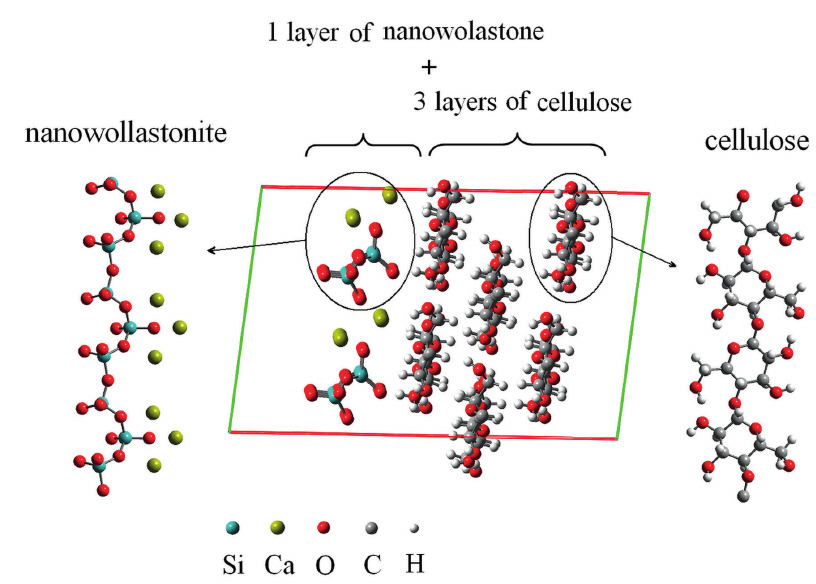
Figure 4 - Schematic representation of bond formation between Calcium atoms of NW and Oxygen atoms of cell-wall cellulose chains (Taghiyari et al.